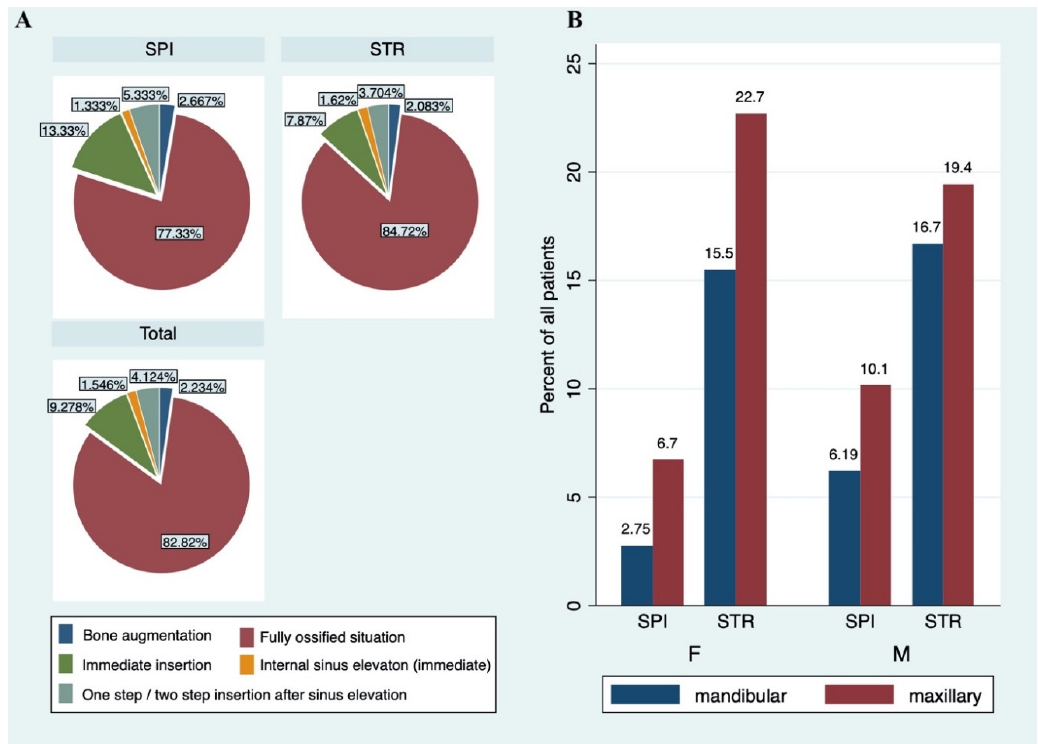
Figure 2. Distribution of the bone insertion technique, stratified by implant system ( A ) and distribution of sex, implant system, and implant location shown as percentage of all patients in our study cohort ( B ) ( n = 582). STR: Straumann implants; SPI: Thommen implants; F: female; M: male.